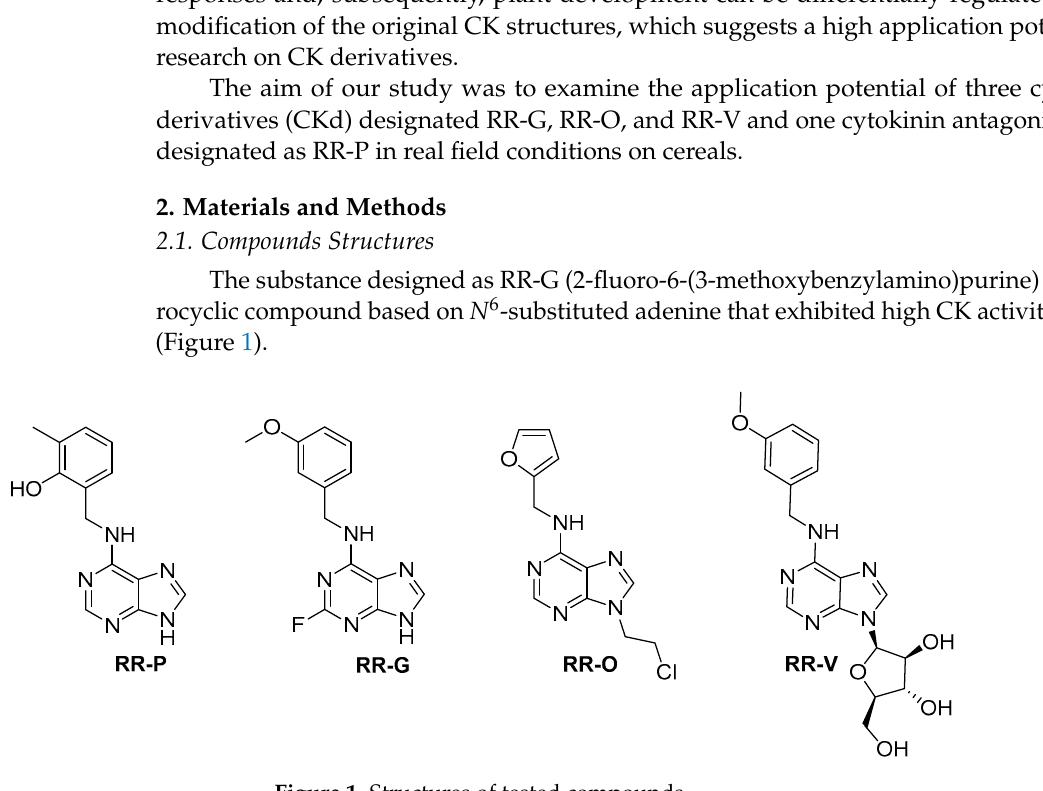
Figure 1. Structures of tested compounds.